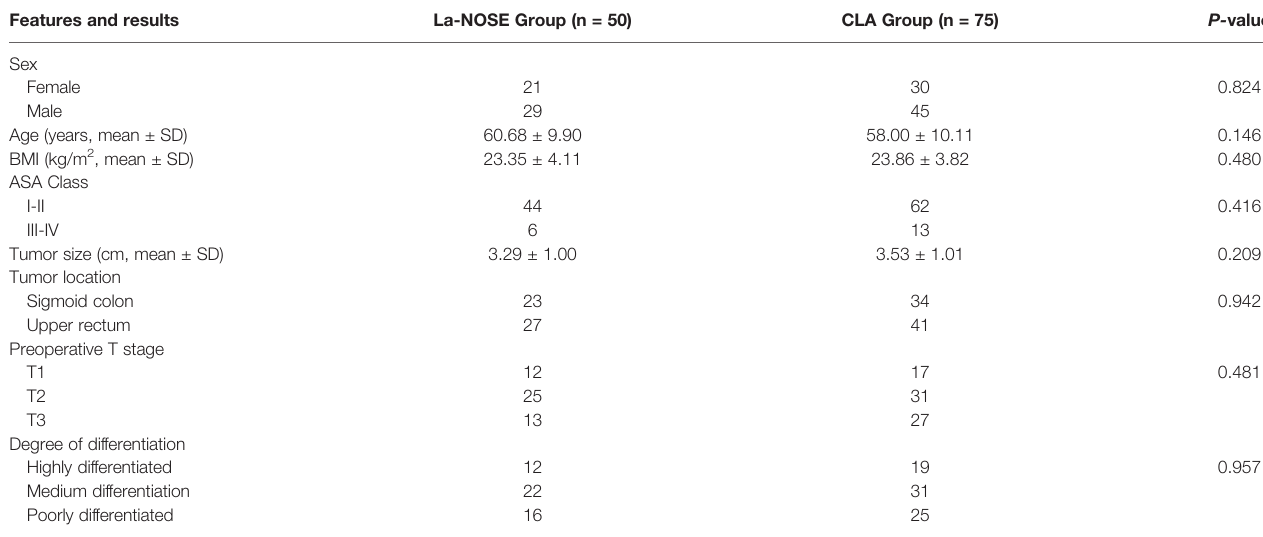
TABLE 1 | Clinical and pathological